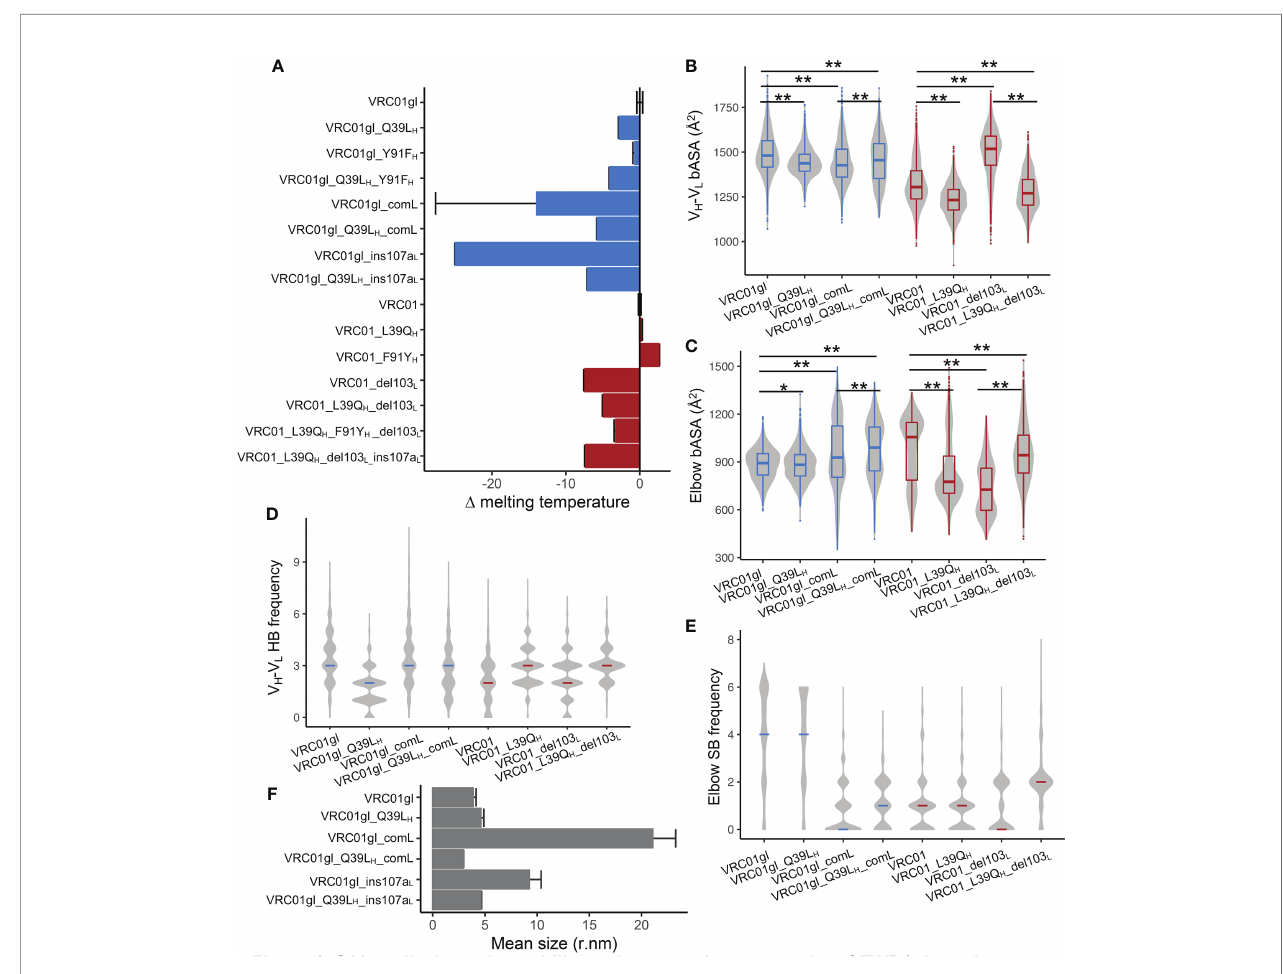
FIGURE 4 | Q39L H alleviates the stability and aggregation propensity of FWR4 L insertion. (A) Effects of somatic hypermutations on VRC01gl and VRC01 melting temperature. Data are shown with mean and SD from two replicates. (B) Buried accessible surface area between V H and V L domains obtained from MD simulation. MD repeats were combined for each antibody variant. (C) Buried accessible surface area between variable and constant domains obtained from MD simulation. MD repeats were combined for each antibody variant. (D) Frequencies of hydrogen bonds at V H -V L interface in MD simulation. Median was highlighted by line. (E) Frequencies of salt bridges at elbow interface in MD simulation. Median was highlighted by line. (F) Effects of somatic hypermutations on VRC01gl and VRC01 Fab protein size. Data are shown with mean and SD from three replicates. Kolmogorov – Smirnov test is used to compare the signi fi cance of difference for panels (B, C) . P values less than 0.01 are labeled with two stars. P values greater than 0.01 and less than 0.05 are labeled with one